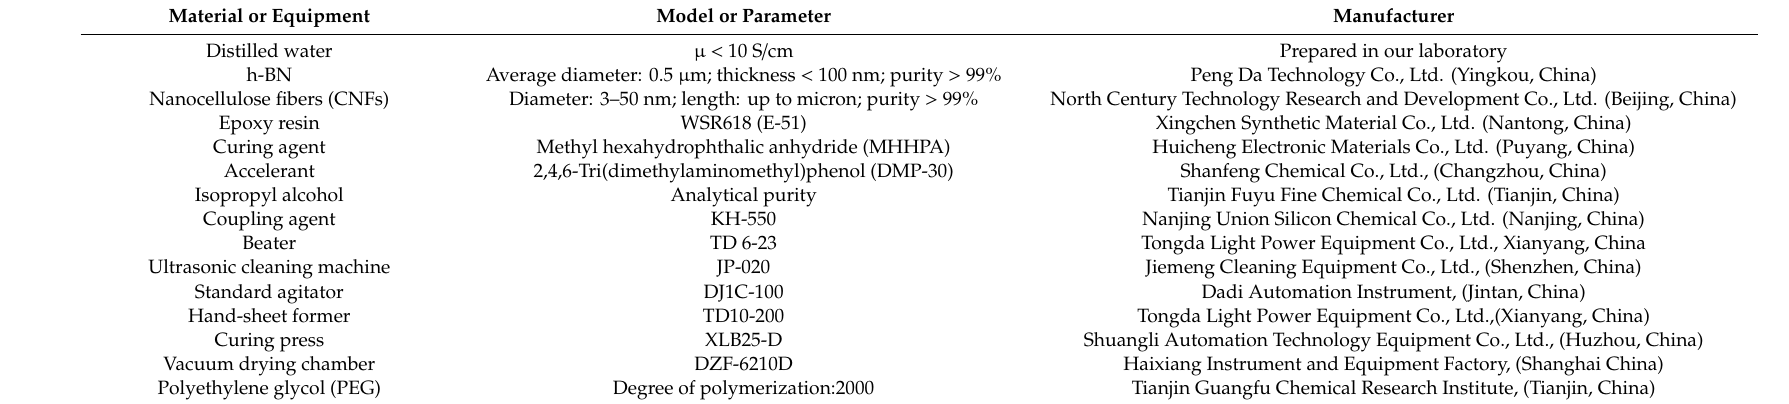
Table 1. Material parameters and equipment